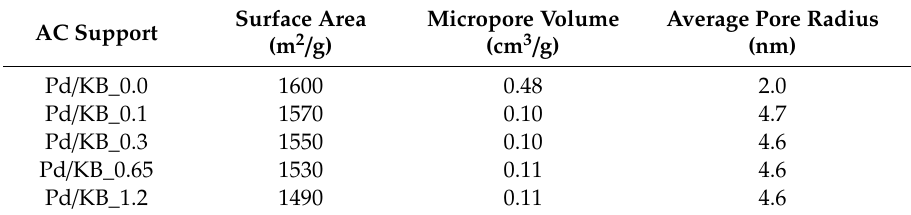
Table 3. BET results for the bare activated carbon